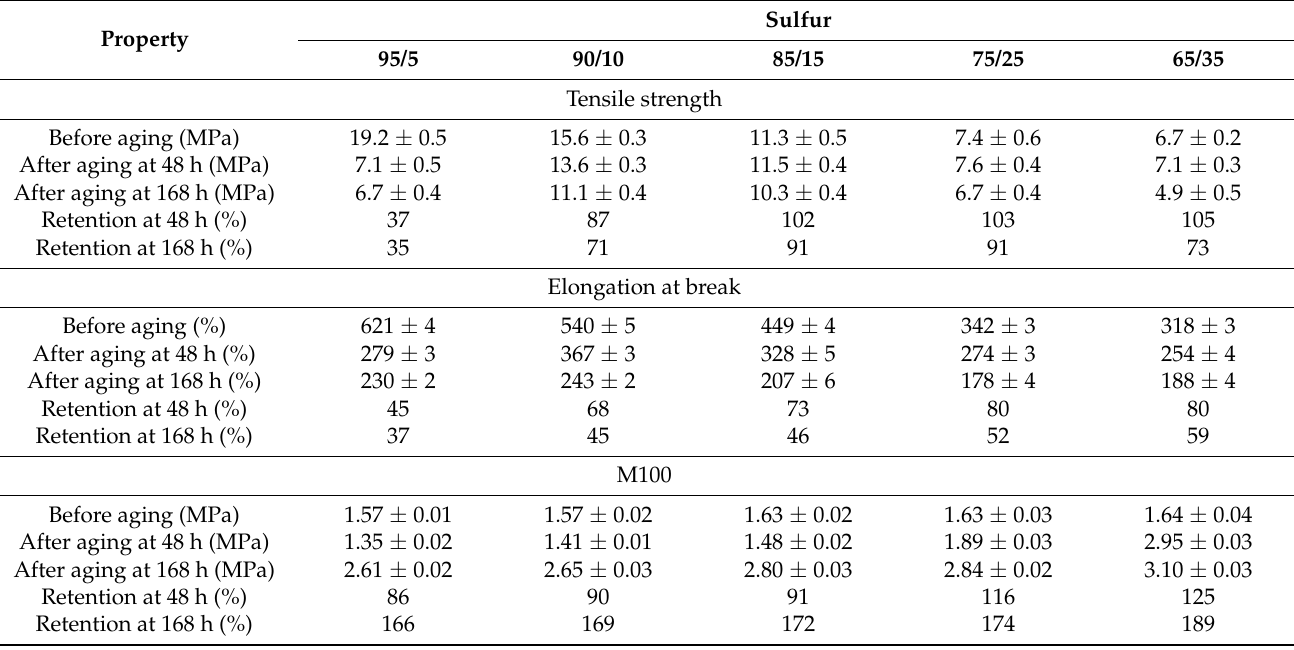
Table 3. Heat aging of NR/r-NBR blends prepared with S crosslinking systems.